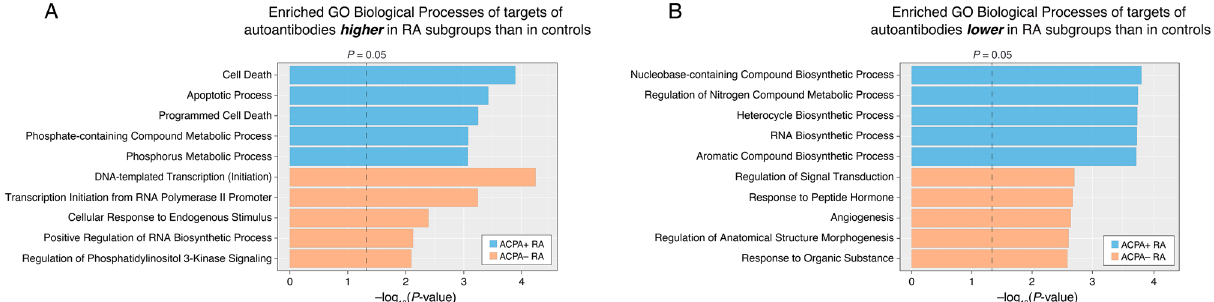
Figure 4. Human protein antigens (potential autoantigens) targeted by the differentially abundant serum autoantibodies are enriched in fundamental cellular functions. The top 5 statistically enriched biological processes of the antigen targets of the autoantibodies found to be significantly ( A ) higher and ( B ) lower in RA subgroups (ACPA+ , ACPA− ) compared with healthy controls. Enriched (i.e., over-represented)